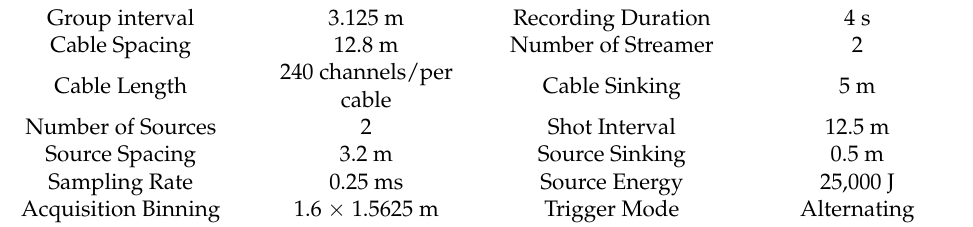
( b ) Figure 6. Seismic profiles obtained in shallow water north of the South China Sea. ( a ) Seismic pro- file; ( b ) Velocity spectrum.